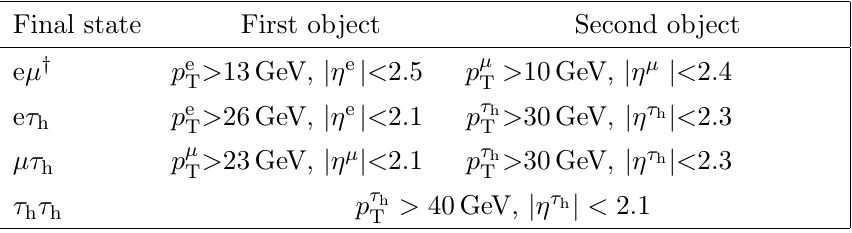
Table 1 . Kinematic selection of the (cid:28) lepton decay products in the e (cid:22) , e (cid:28) h , (cid:22)(cid:28) h , and (cid:28) h (cid:28) h (cid:12)nal states. The expression \First (Second) object" refers to the (cid:12)nal state label used in the (cid:12)rst column. VeryLoose working points. These have e(cid:14)ciencies of 27% (Tight), 51% (Medium), and 71% (VeryLoose), for quark/gluon misidenti(cid:12)cation rates of less then 4 : 4 (cid:2) 10 (cid:0) 4 (Tight), 3 : 3 (cid:2) 10 (cid:0) 3 (Medium), and 1 : 3 (cid:2) 10 (cid:0) 2 (VeryLoose). Finally, requirements are imposed to here prede(cid:12)ned working points are used to discriminate against electrons, with